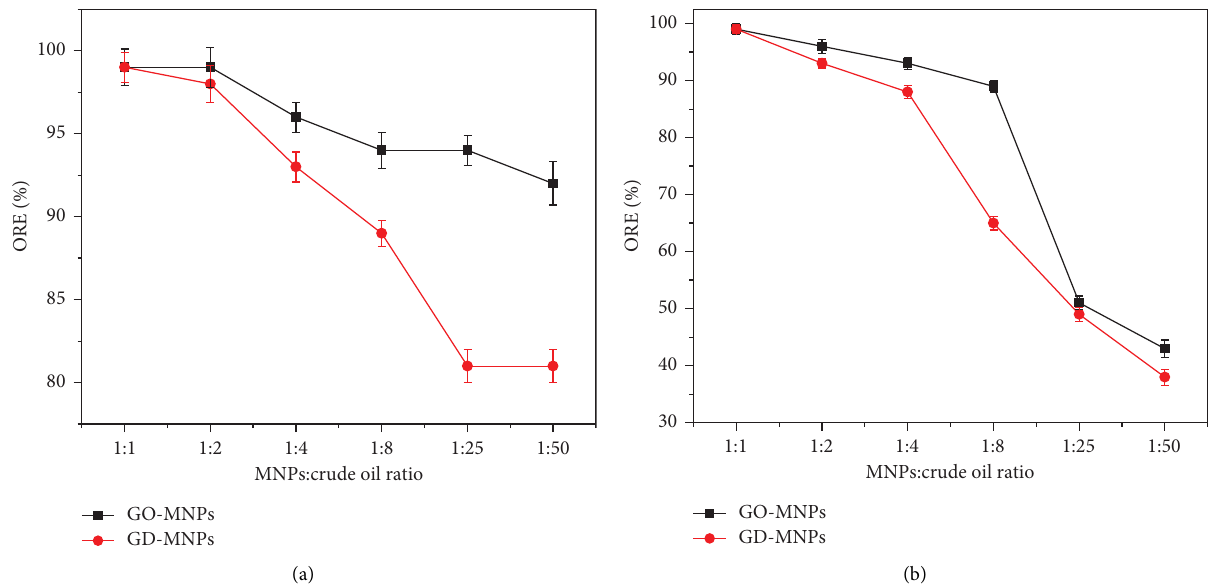
Figure 9: Oil removal efciency (ORE%) of GO-MNPs and GD-MNPs using (a) method A and (b) method B.